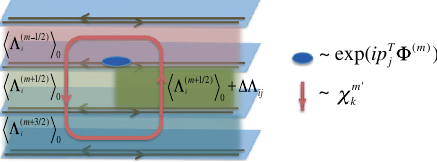
FIG. 5. This figure illustrates the braiding between two qua- siparticles of the surface topological order on the side surface. The blue dot represents the quasiparticle w created by the j operator e ip T j Φ ð m Þ . The red line represents the trajectory of the second quasiparticle w that the first one braids with. The k operators that tunnel w along the trajectory are explained in the k main text. Especially, the vertical tunnel operator from the m 0 th layer to the ( m 0 þ 1 )th layer is given by χ m 0 k i 0 are pinned to the i i 0 i i